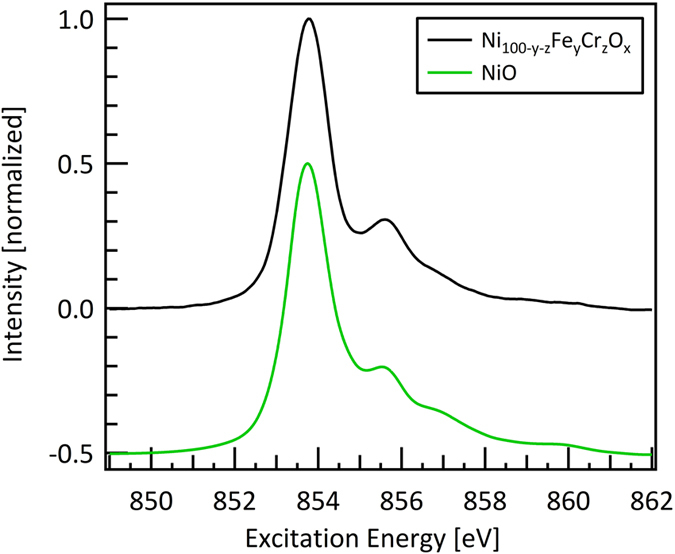
Ni L3-edge of Ni1-y-zFeyCrzOx.The Ni L3-edge was found to be constant across the entire materials library. The NiO reference spectrum is adopted from22 and shifted downwards by 0.5 for better readability.